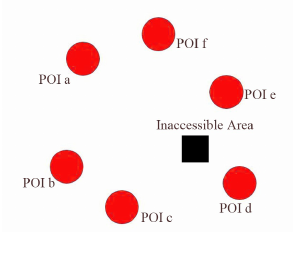
Figure 11. Division of test area